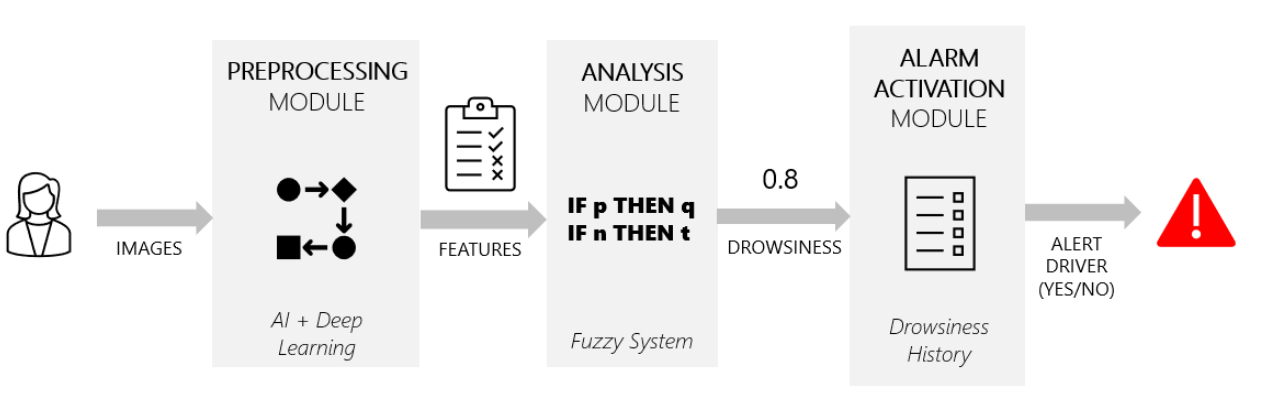
Figure 6. Alternative II